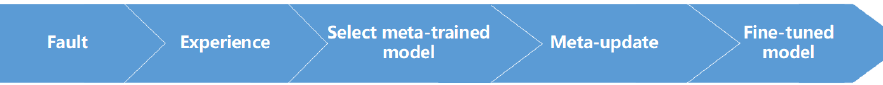
Figure 2. Flowchart of the meta-DDPGSE-based FTC